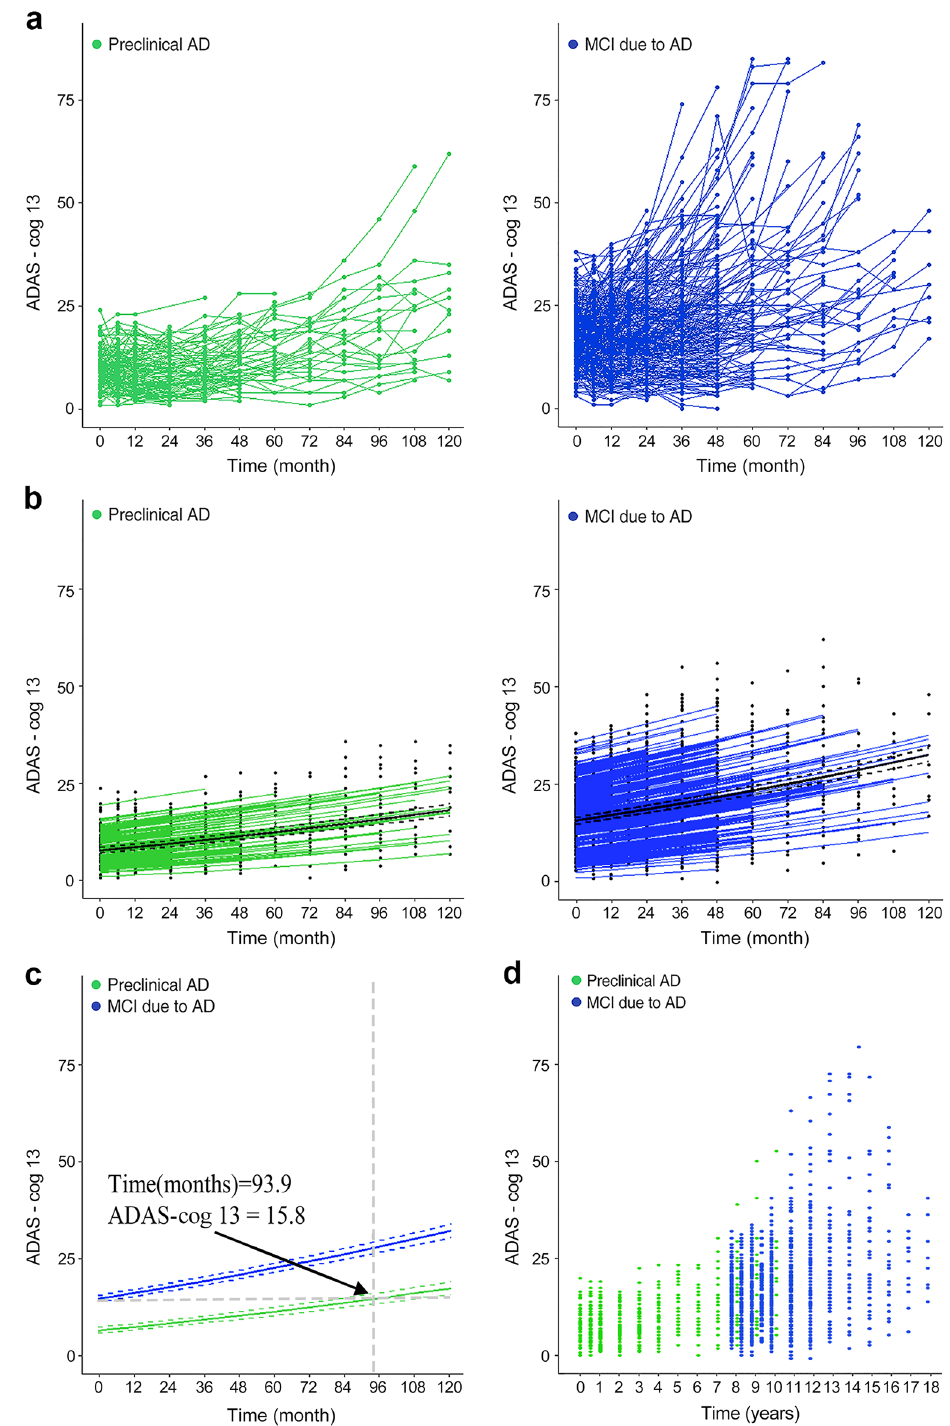
Figure 2. Modelling the course of Alzheimer’s disease using ADAS-cog 13 scores. ( a ) The pattern of individual ADAS-cog 13 scores in individuals with preclinical AD and MCI due to AD. ( b ) The estimated ADAS-cog 13 scores over time for each subject and for each cohort, obtained from a linear mixed effects model with time as a fixed effect and subjects as a random effect (excluding outliers). Green and blue lines mean the estimated ADAS-cog 13 score for each subject at the time for preclinical AD and MCI due to AD, respectively. Black solid and dotted lines mean the estimate and 95% confidence interval (CI) for mean ADAS-cog 13 score at the time. ( c ) The estimated mean ADAS-cog 13 score and the corresponding time for two cohorts to start to overlap. Solid line means the estimated mean ADAS-cog 13 score and dotted lines mean 95% CI of the estimated mean ADAS-cog 13 score. ( d ) Scatter plot of the combined preclinical AD and MCI due to AD cohorts shifted by the time of 93.9 months, corresponding to an ADAS-cog 13 score of 15.8 points. ADAS-cog: Alzheimer’s Disease Assessment Scale-cognitive subscale, MCI: mild cognitive impairment; AD: Alzheimer’s